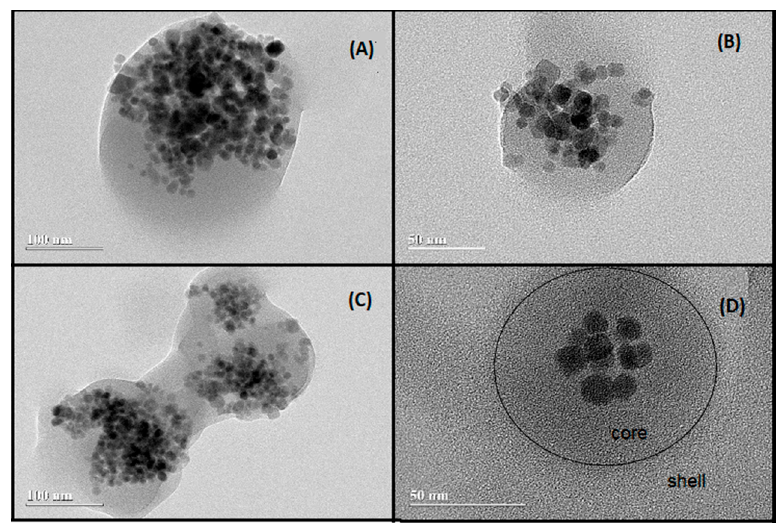
Figure 4. ( A ) and ( B ) Micrographs captured by TEM of the PMMA/OM-OA and ( C ) and ( D ) Figure 4. ( A , B ) Micrographs captured by TEM of the PMMA / OM-OA and ( C , D ) micrographs recorded micrographs recorded by TEM of the core–shell poly(methyl methacrylate) nanoparticles byTEMofthecore–shellpoly(methylmethacrylate)nanoparticles(PMMA) / OM-OA / (PMMA)/OM-OA/PVPi nanoparticles.